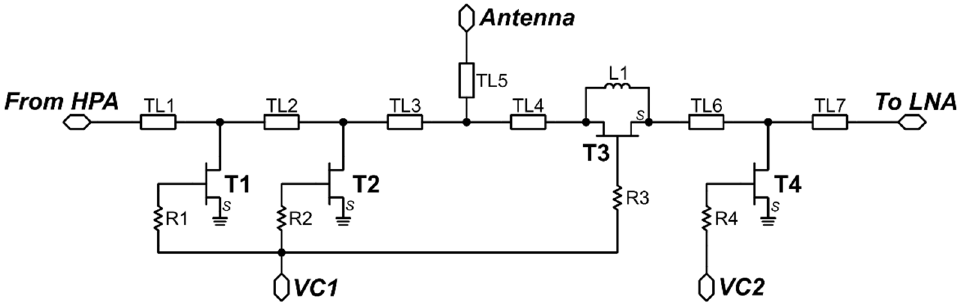
Figure 2. Schematic of the SPDT circuit.